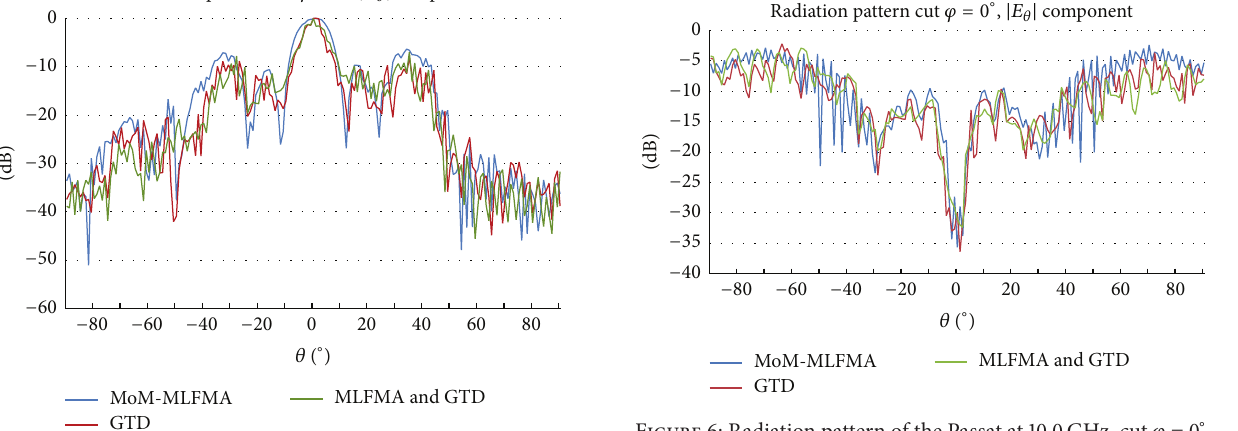
Figure 6: Radiation pattern of the Passat at 10.0GHz, cut 𝜑 = 0 ∘ .